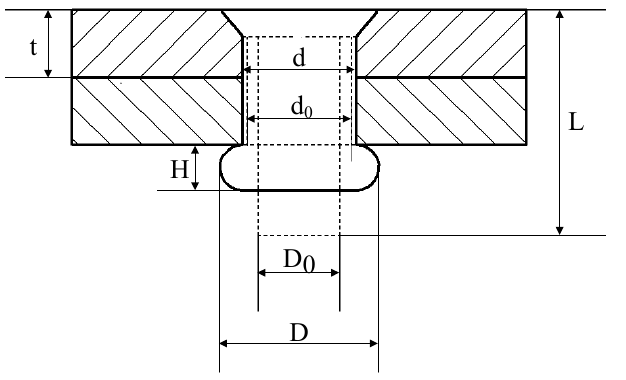
Figure 2. Interference-fit riveting process. ( a ) Rivet starts to deform and fill the hole, but not yet contact with plates; ( b ) Rivet contacts plates and the driven head starts to form; ( c ) The driven head is formed and rivet is in full contact with plates; ( d ) The riveting bar retreats and the spring-back of the riveted joint occurs; and ( e ) Riveting bar separates from rivet; the riveting process is over.